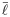
Expression of Capricious in clones of cells leads to smooth clone borders and increased cell bond tension at the clone border.(A,B) Wing discs of wandering stage third instar larvae displaying control clones (A) or clones expressing Capricious (B, Act5C>Gal4, UAS-caps) marked by the expression of CD8-mCherry (red) and stained for E-cadherin (green). Scale bars: 30 μm. (C,D) Magnification of the inset in (A,B). Scale bars: 10 μm. (E,F) Segmentation of the images shown in (C) and (D). The clones are marked in blue. (G) Clonal roughness for control clones and clones expressing Capricious. Segment length and clonal roughness values are normalized by the average cell bond length in the tissue l¯ = 1.7 μm. Mean and s.e.m. are shown (control, n = 6 wing discs; mutant, n = 4 wing discs), P <0.001–0.05 for L = 3–10. (H) Change in distance d between the vertices at borders of control clones or of clones expressing Capricious after ablation (normalized to l¯) as a function of time. Mean and s.e.m. are shown (control, n = 7; caps, n = 11 cuts). (I) Initial velocity of vertex displacement after ablation of cell bonds indicated in (H). Mean and s.e.m. are shown (n as in H). ** P<0.01.